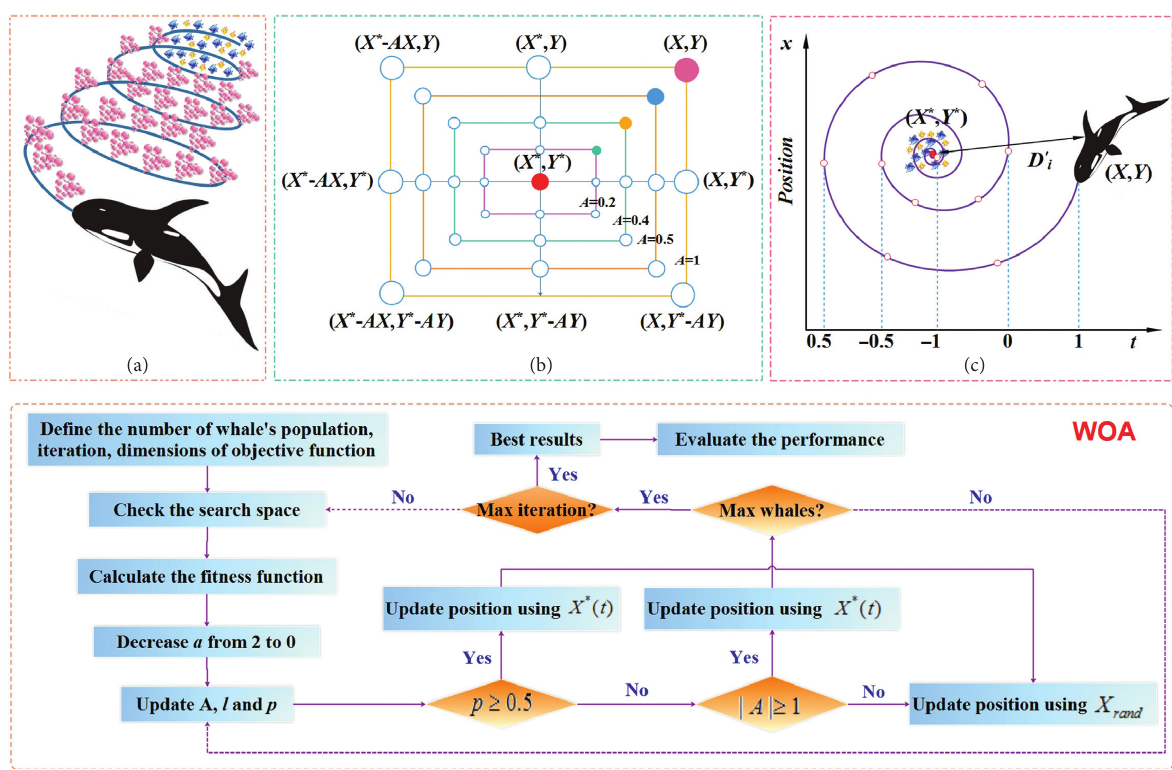
Figure 2: Bubble-net search mechanism that is implemented in WOA: (a) the bubble-net feeding behavior of humpback whales, (b) the shrinking encircling mechanism, and (c) the spiral position